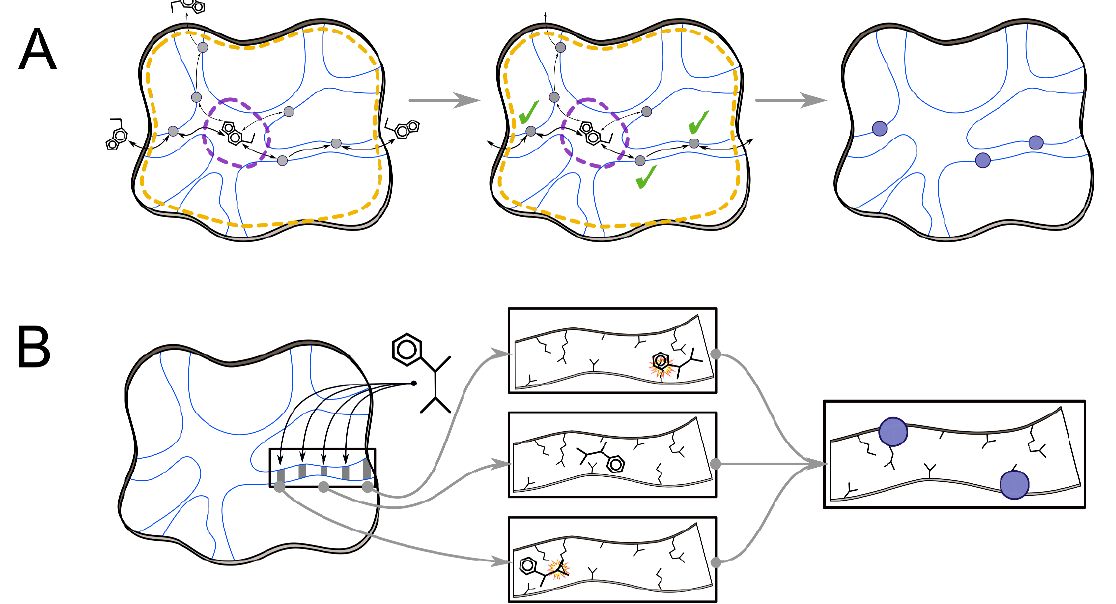
Figure 3. Hotspot detection based on ligand transport analyses. ( A ) AQUA-DUCT tool traces the movement of ligands via void spaces (blue lines) inside the scope region (dotted orange shapes) of the protein moiety throughout an MD trajectory. Only the ligands that reach the functionally important object region (dotted violet ellipses) are considered. The significance of the interactions of transported ligands with residues (grey spheres) along the ligand trajectory (black arrows) can be evaluated to select relevant hotspots (blue spheres) for the modification of the transport kinetics. ( B ) By iteratively docking the ligand along a molecular tunnel, CaverDock estimates the energy profile of a ligand transport, indicating residues that are most likely responsible for energy barriers in the path. These residues represent hotspots (blue spheres) for the design of new protein variants with altered ligand transport.